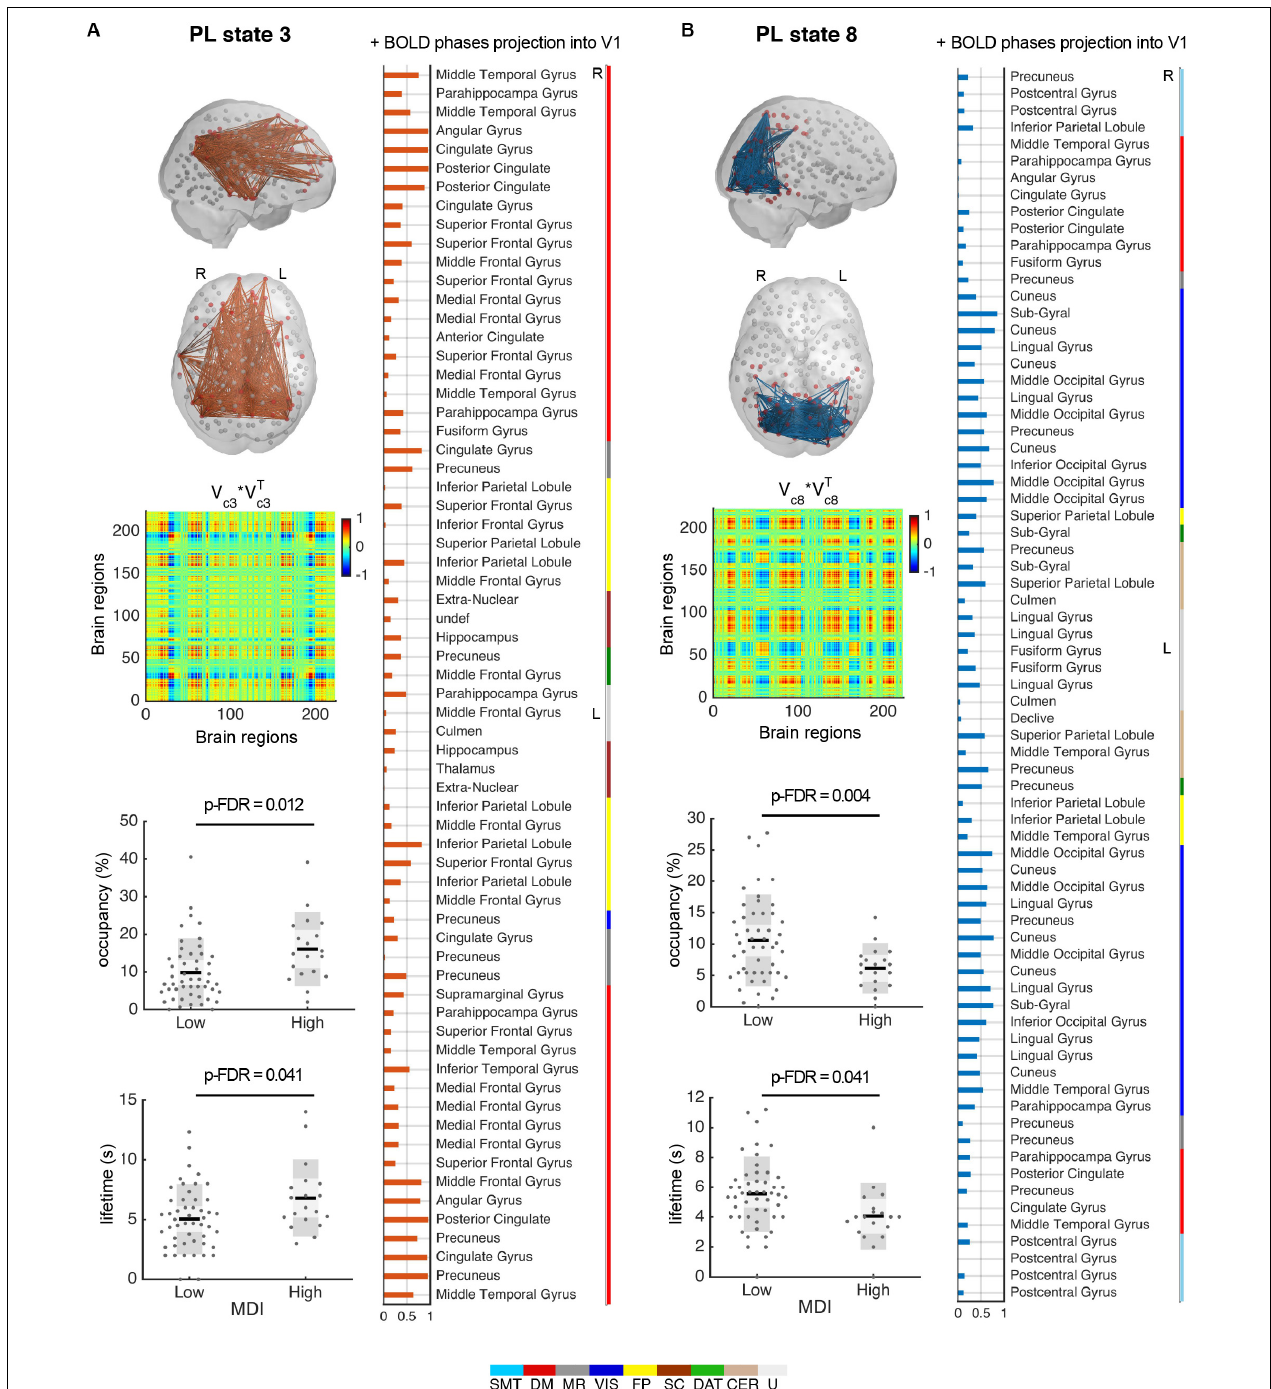
FIGURE 4 | PL states 3 (A) and 8 (B) significantly differ for high compared to low MDI. (top left) Each PL state is represented in the cortical space, where functionally connected brain regions (represented as spheres) are colored in red. Links between vector elements with Vc(n) > 0.3 are drawn to highlight the configuration captured by each centroid. PL states are also represented as the outer product of Vc, which is a 223 × 223 matrix representing the number of brain regions, where positive (red) values indicate the product of Vc elements with the same sign, be they positive or negative. (right) Bar plot showing the elements in Vc with positive BOLD phase, representing the projection into the leading eigenvector. Vertical color bars indicate the network assigned to a given region. (bottom left) Significant (p-FDR < 0.05) differences in the percentage of occurrence and lifetime between low and high MDI. Dots represent individual data points; dark gray bars represent standard deviation, and lighter bars indicate standard error of the mean (represented by a horizontal line). Analysis via non-parametric permutation-based t -test ( N = 69 participants). DAT, dorsal attention; DM, default mode; FP, frontoparietal task control; L, left; MDI, Major Depression Inventory; MR, memory retrieval; PL, phase-locking; R, right; SC, subcortical; SMT, sensorimotor; s, seconds; VIS, visual; CER, cerebellar; U, uncertain (visual-related network).